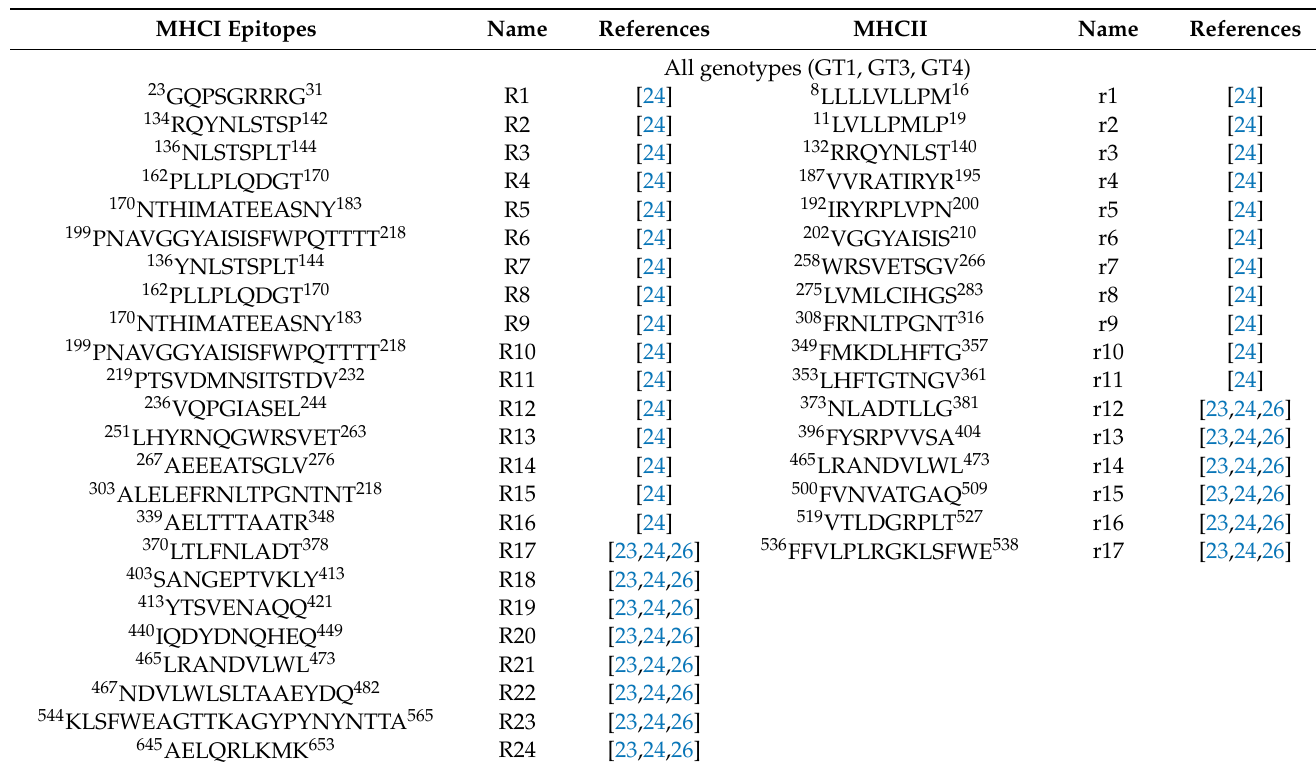
Table 1. Finalized epitopes for the HEV vaccine